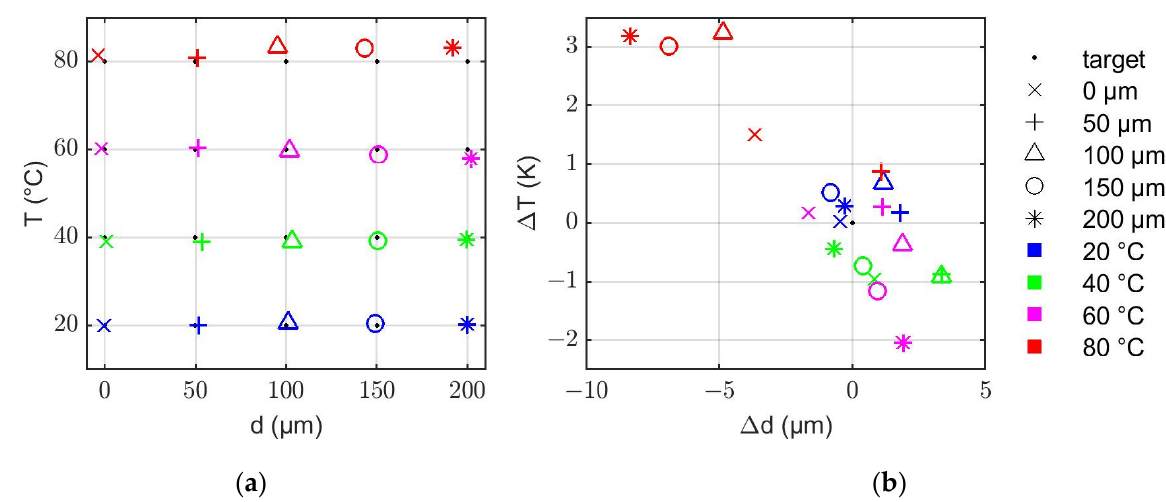
Figure 8. ( a ) Test grid with the evaluated values for the layer thickness d and temperature T based on the simulated propagation times t D and t V displayed in Figure 7. ( b ) Absolute deviation of the evaluated data from the test grid.